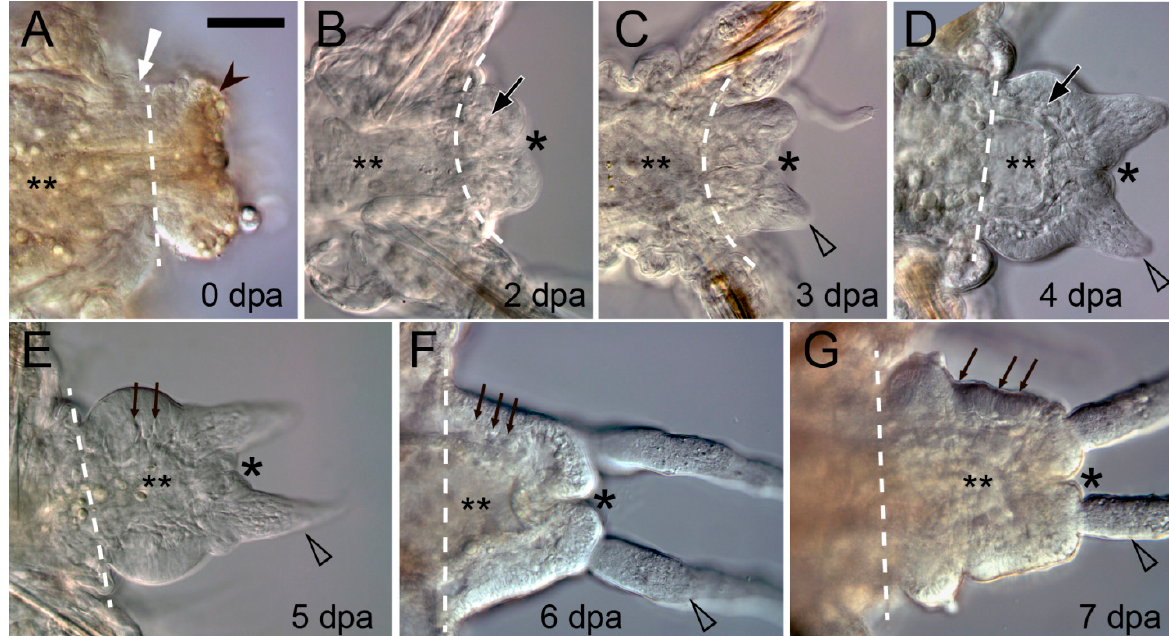
Figure 4. Posterior regeneration in a juvenile polychaete Platynereis dumerilii (Errantia, Nereididae). Optical frontal sections of live anesthetized ( A , F , G ) or fixed and glycerol-cleared ( B – E ) specimens 0 to 7 dpa; posterior end is to the right. Asterisk, anus; dotted line, plane of amputation; double asterisk, gut lumen; white arrow in ( A ), constriction of circular muscles; black arrowheads in ( A ), protruded and curled out gut; triangles in ( C – G ), forming pygidial cirrus; large arrows in ( B , D ), mesodermal cells of the regeneration blastema; small arrows, segmental boundaries in mesodermal ( E , F ) or ectodermal ( G ) tissues. Scale bar 50 μ m.